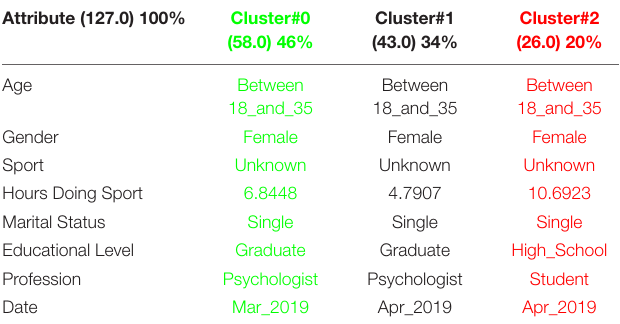
TABLE 13 | 3 clusters AF5 analysis for March to May 2019.